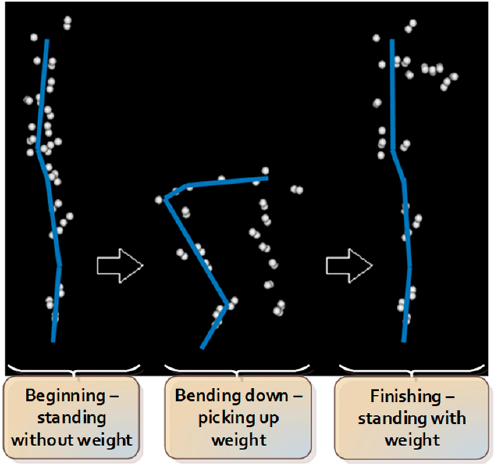
Figure 2. Sequence of consecutive actions during lifting. Kinematic data were collected using non-reflective markers placed on the participants’ skin to mark the head, trunk, pelvis, upper and lower limbs [22]. A 12-camera motion analysis system (Optitrack Flex 13, NaturalPoint, Corvallis, OR, USA) with 120 Hz sampling rate was utilized to provide the three-dimensional recording of anatomical landmarks. Kinematic data were grouped, named, cleaned and gap-filled using Optitrack Motive software (NaturalPoint, Corvallis, OR, USA). The data were then passed through to a custom-written analysis pipeline of Visual3D v5.01.6 (C-Motion, Inc., Germantown, MD, USA). Angular displacement and velocity data of different joints in all planes were derived using custom-written software (LabVIEW 2009, National